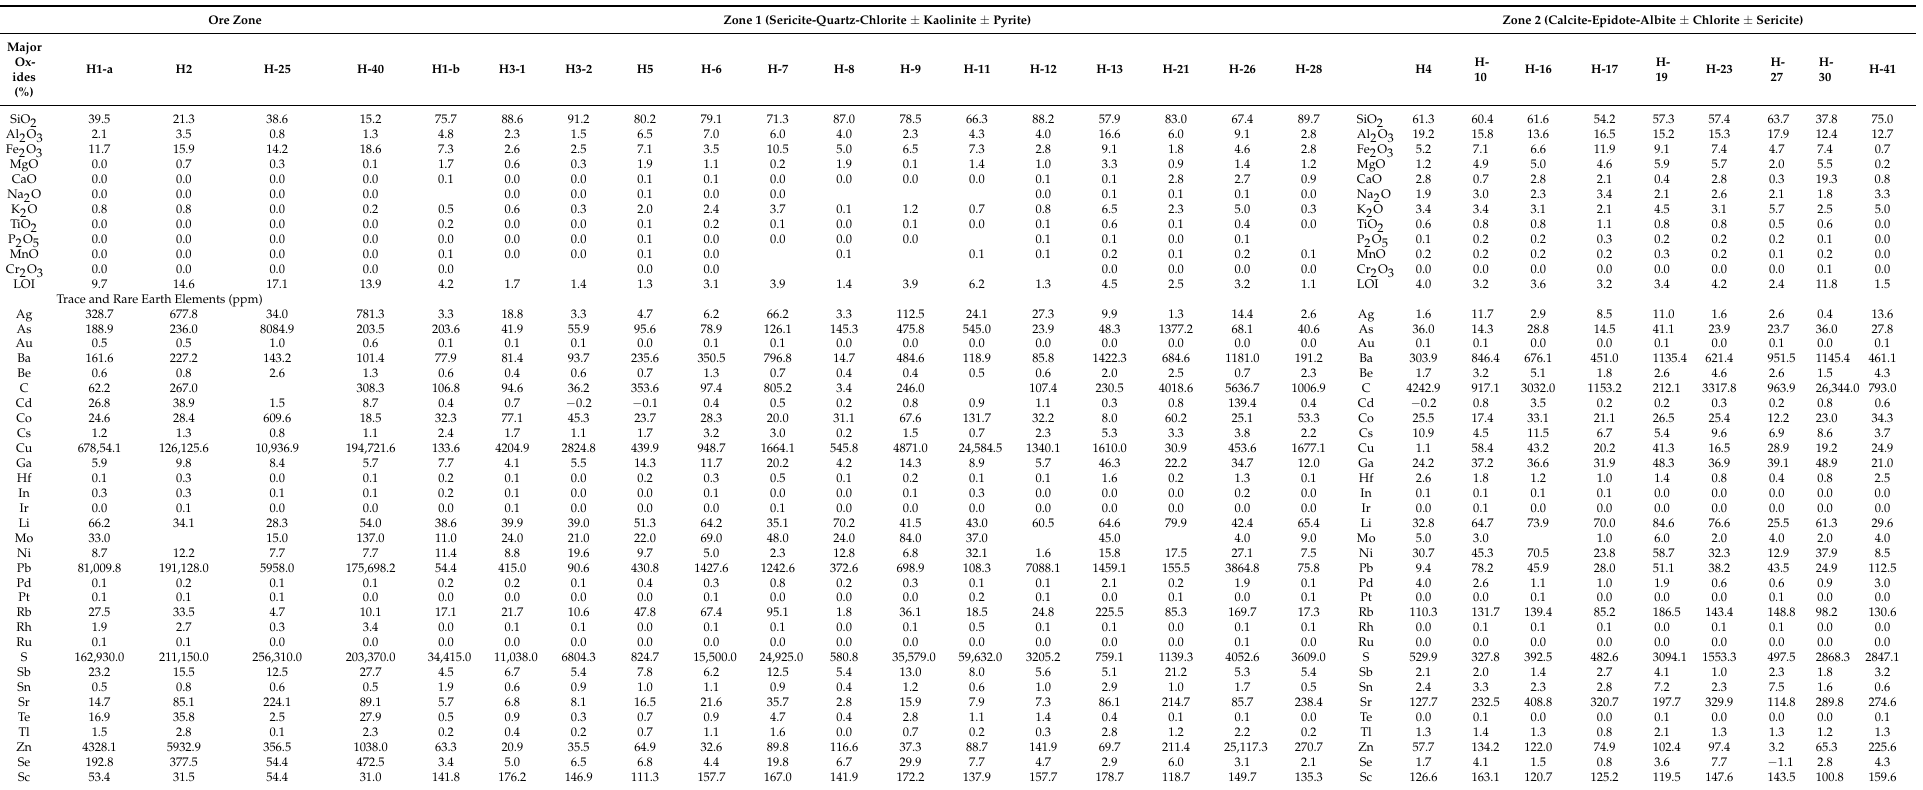
Table 2. Major oxides and trace and rare-earth elements (REE) of the ore zone and alteration zones 1 and 2 in the Halılar area.